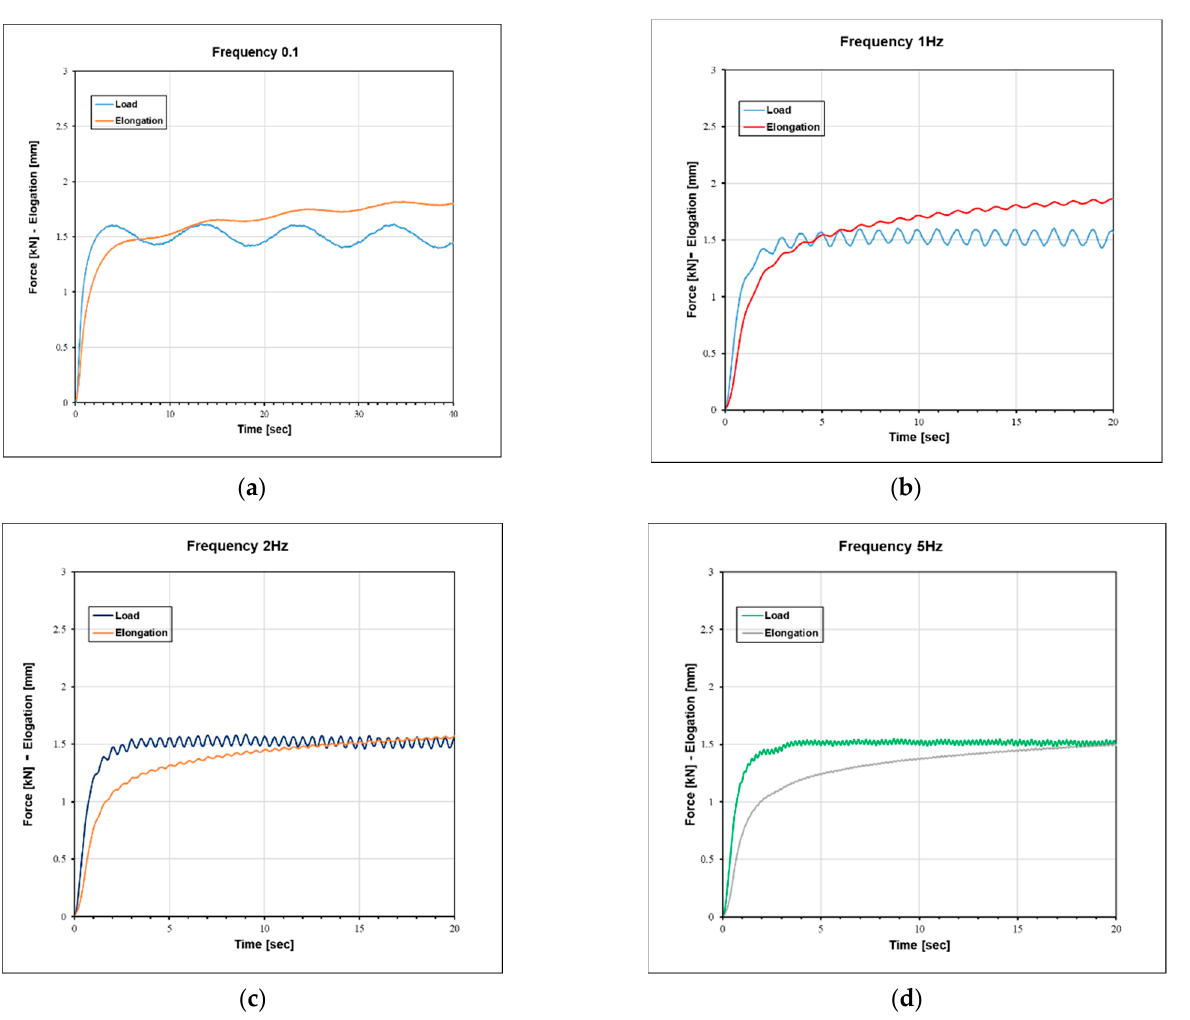
Figure 6. Sinusoidal force causing sinusoidal elongation at different frequencies: ( a ) 0.1 Hz; ( b ) 1 Hz; ( c ) 2 Hz; ( d ) 5 Hz. Table 2. Parameters of the modulus of elasticity of the Dynamica cable at various frequencies.